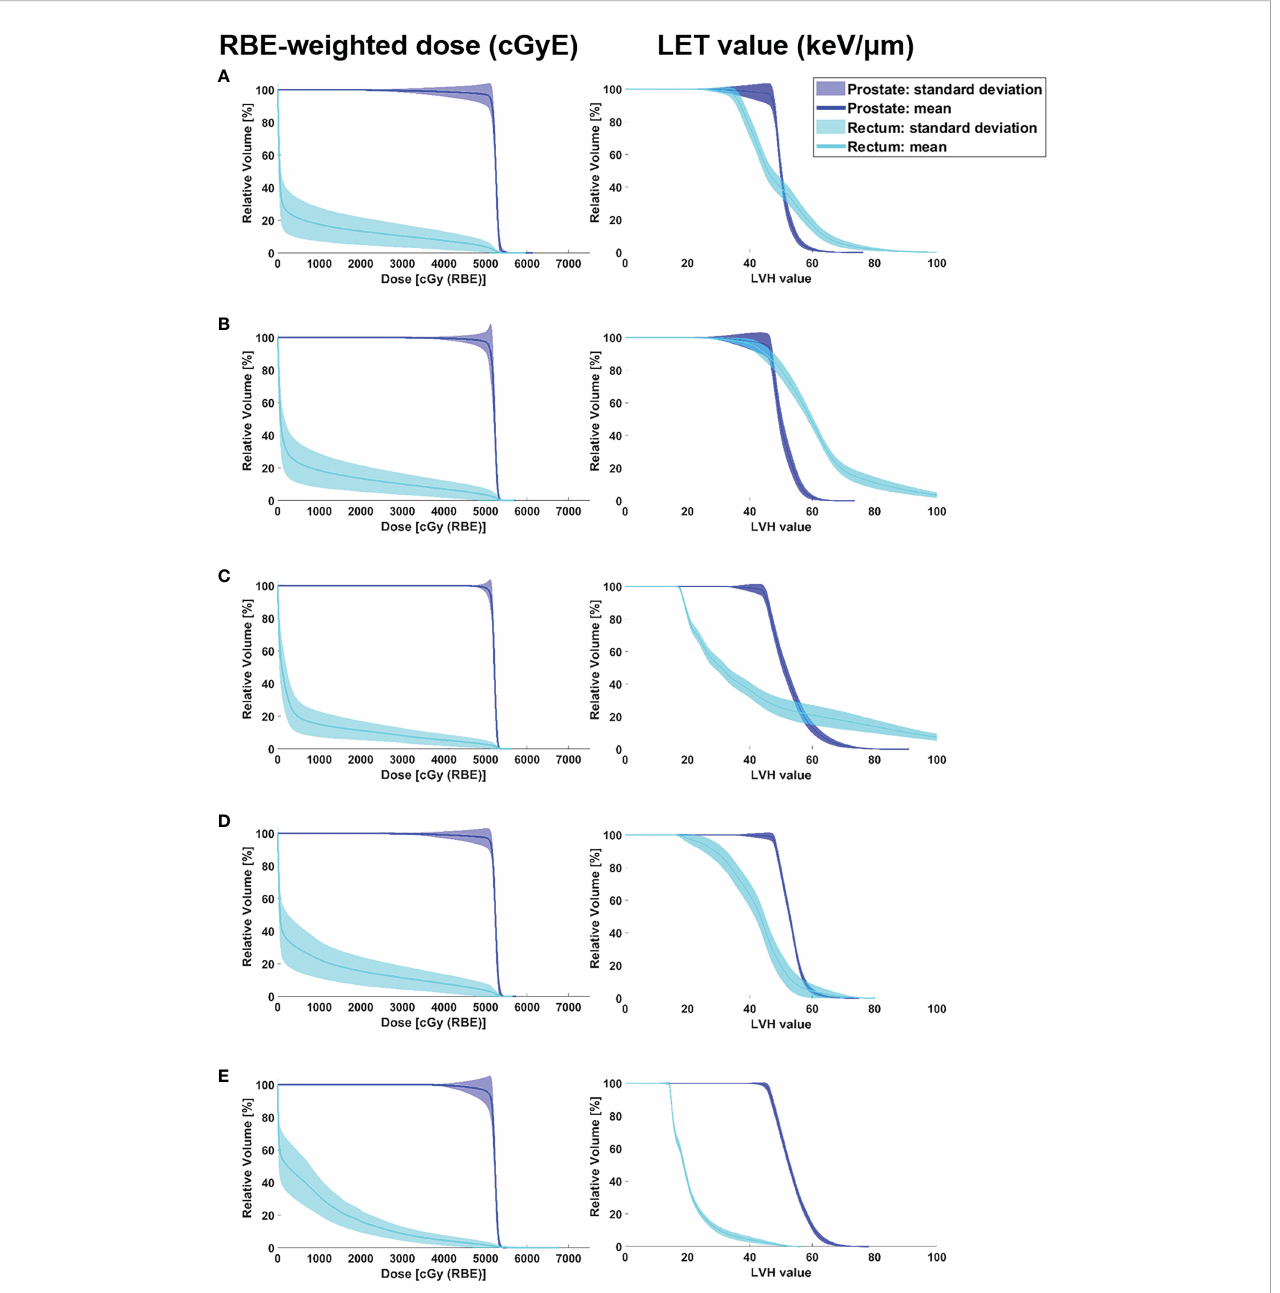
FIGURE 4 RBE-weighted dose volume histograms and LET volume histograms of the prostate and rectum according to angle pair A – E including data of robust evaluation result in all cases. The colour wash represents the standard deviation of DVH bands for dose distributions covering setup uncertainty for the CTV and rectum in the optimised plan, and the solid lines correspond to the DVHs and LVHs for the average value. (A) angle pair A, (B) angle pair B, (C) angle pair C, (D) angle pair D, and (E) angle pair